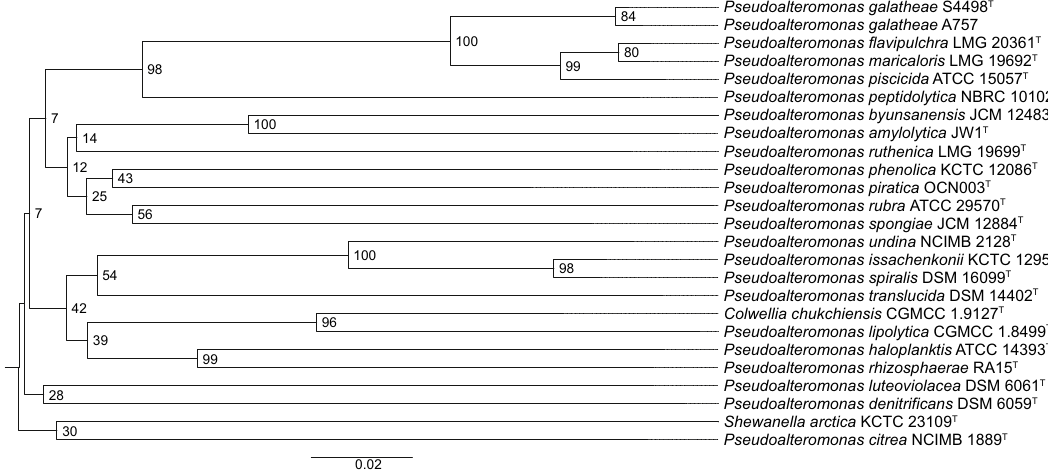
Figure 1. Phylogenomic tree of Pseudoalteromonas species based on genome distances as provided by the TYGS platform 61 . Values are pseudo-bootstraps with average branch support of 59.6%. The tree is rooted at the